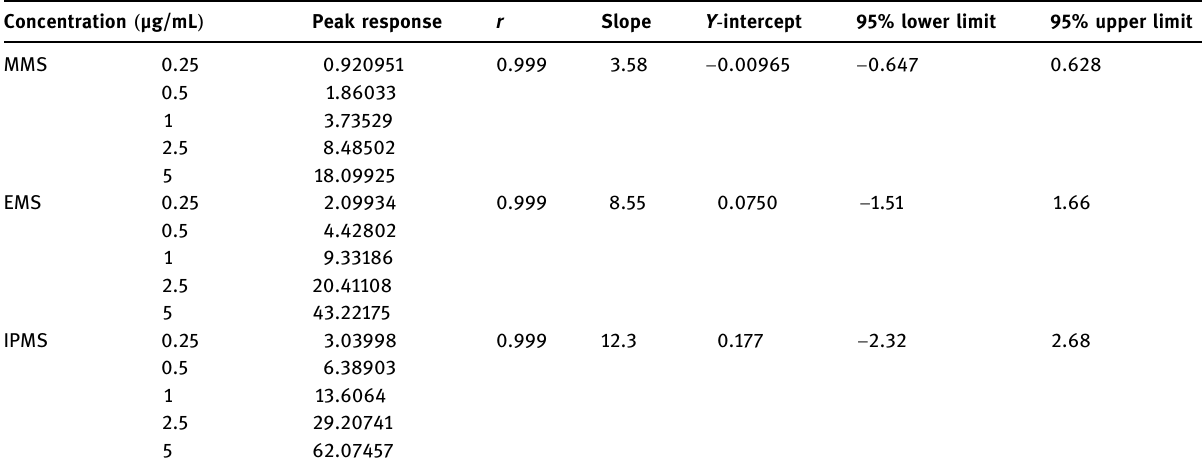
Table 4: Linear regression data of MMS, EMS, and IPMS from 0.25 to 5 µg/mL ( corresponding to 0.5 – 10 ppm in the delgocitinib drug substance ) Concentration ( µg/mL